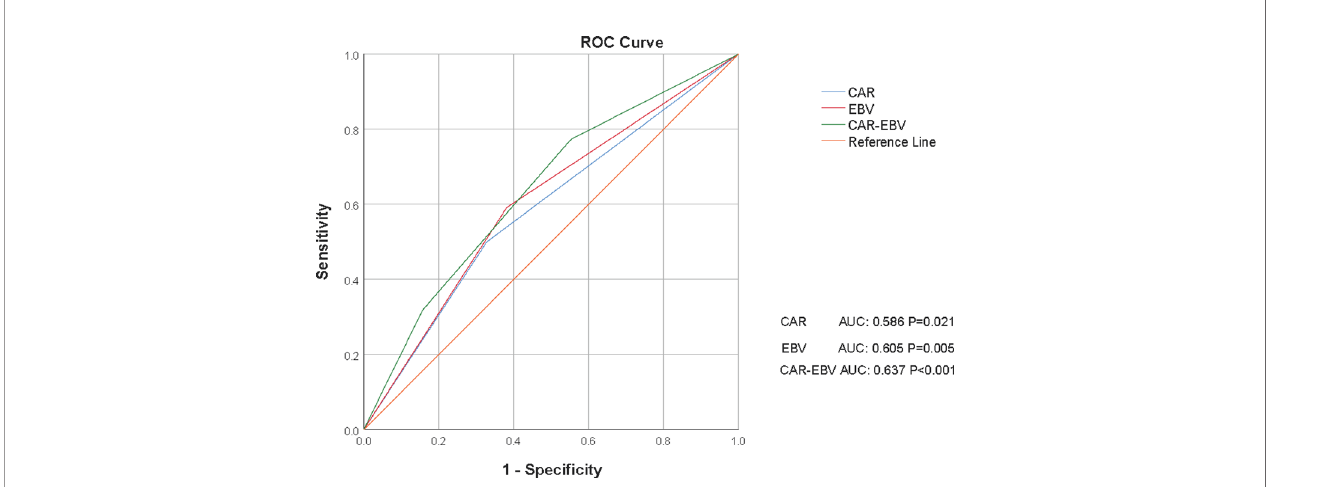
FIGURE 1 | Receiver operating curves (ROCs) for CAR, EBV DNA level, and C-E grade for survival status in the whole cohort. CAR, C-reactive protein/albumin ratio; EBV, Epstein – Barr virus; C-E grade, CAR-EBV DNA